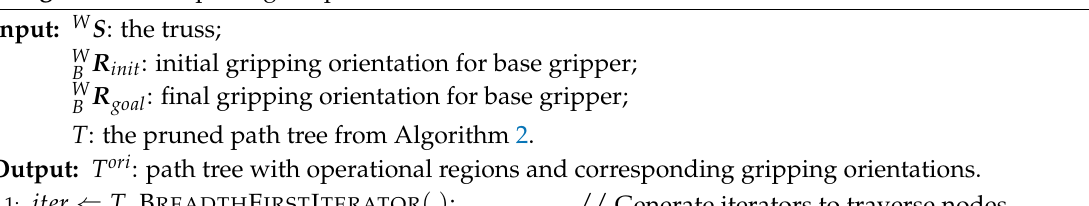
Algorithm 3: Inspecting the path